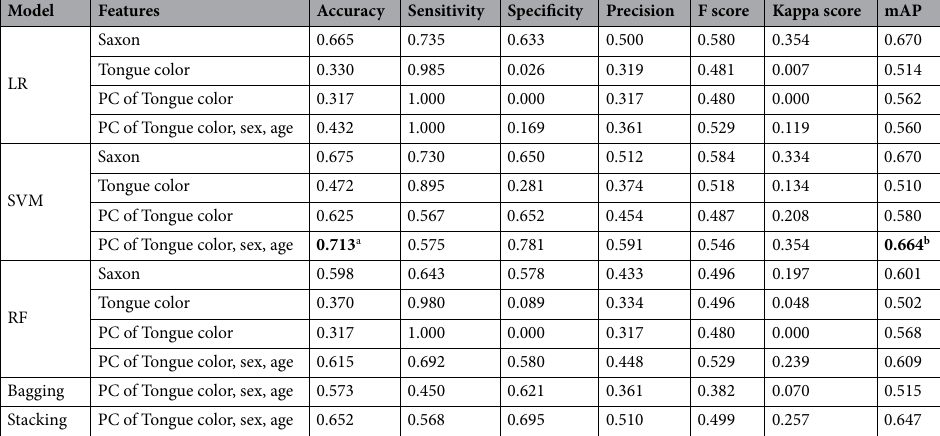
Table 4. Comparison of the mean scores of the cross-validation experiments. a,b SVM trained using PC of Tongue color, sex, and age showed the best accuracy and AP. Significant values are in